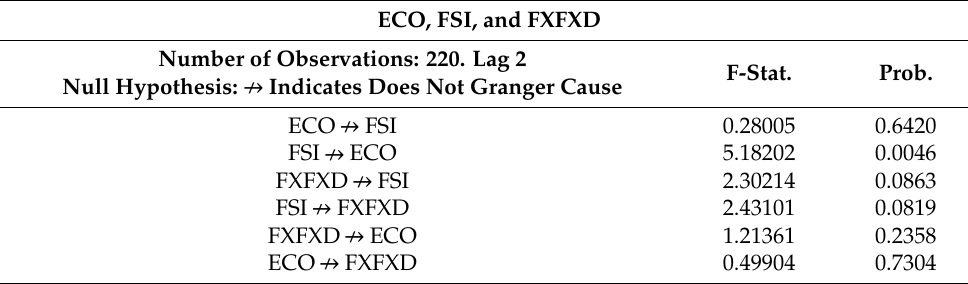
Table 11. VAR residual serial correlation with one GPR. Table 12. Granger causality Tests: ECO, FSI, and FXFXD.